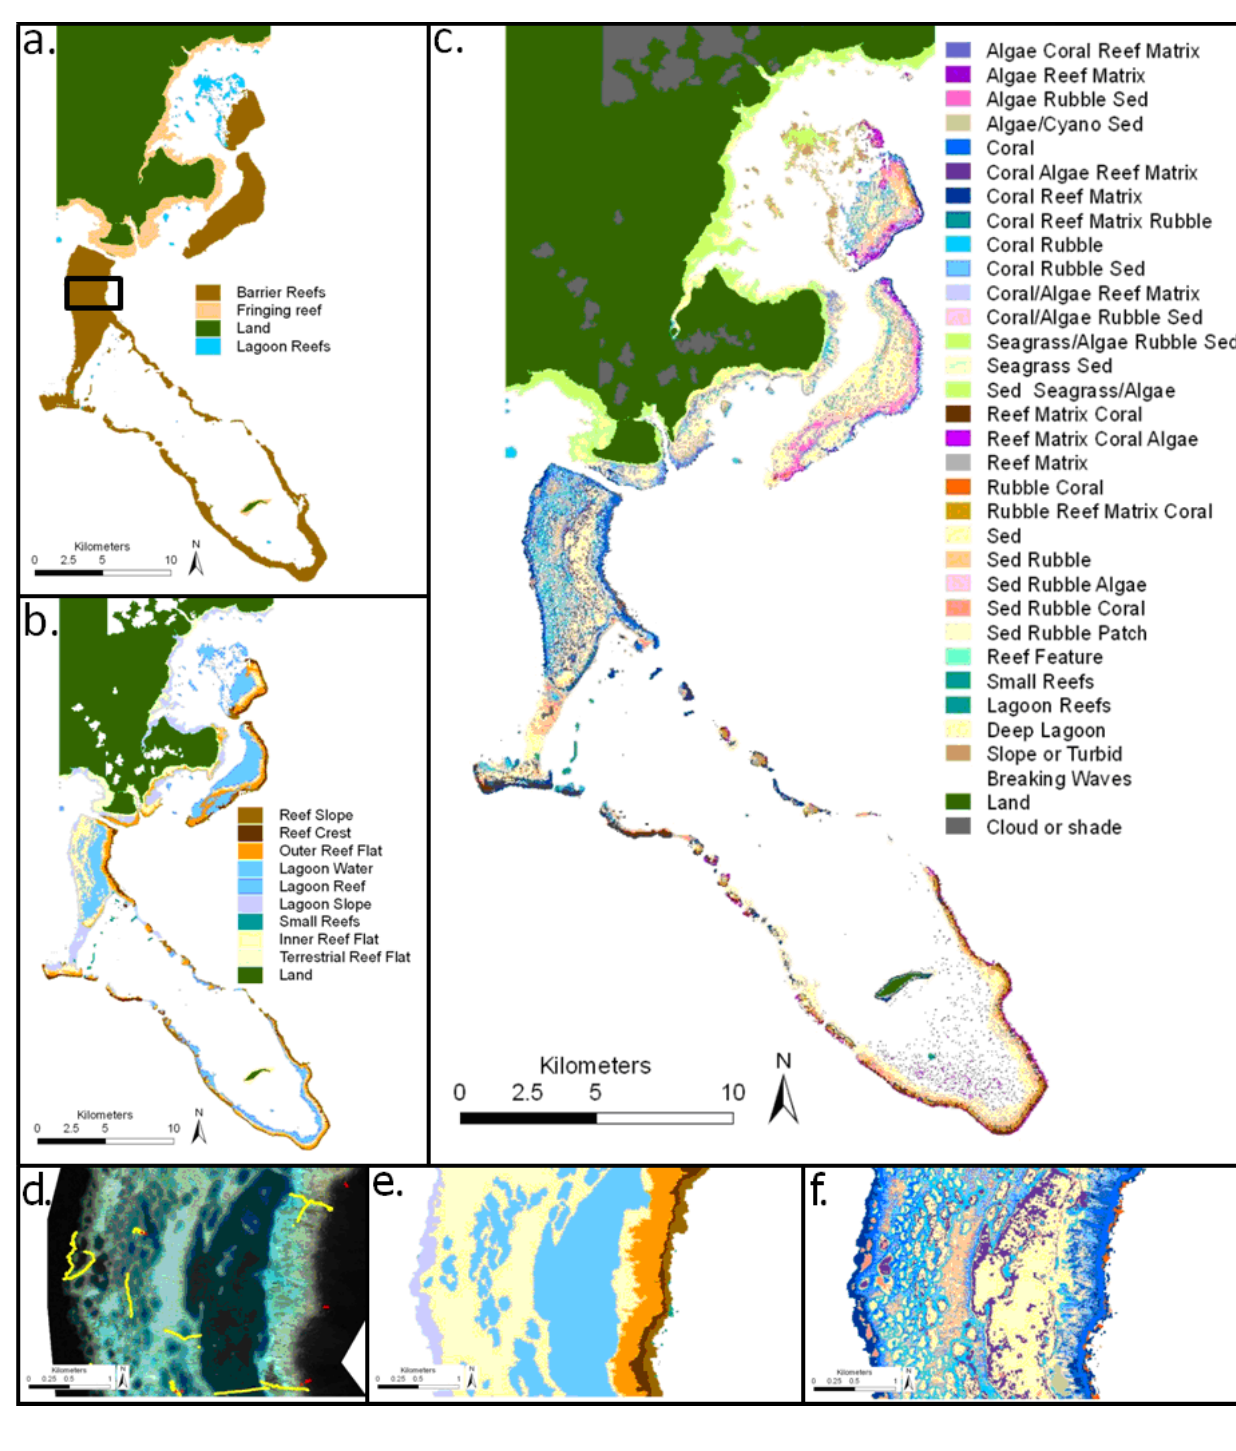
Figure 4. Classification results from areas within Kubulau‘s traditional fisheries management area: (a ) reef type, ( b ) geomorphic zones, ( c ) benthic community, ( d ) subset showing IKONOS true-color composite and transects used to collect benthic field data, ( e ) subset of (b), ( f ) subset of (c). Subset areas outlined by black box in (a). Sed =